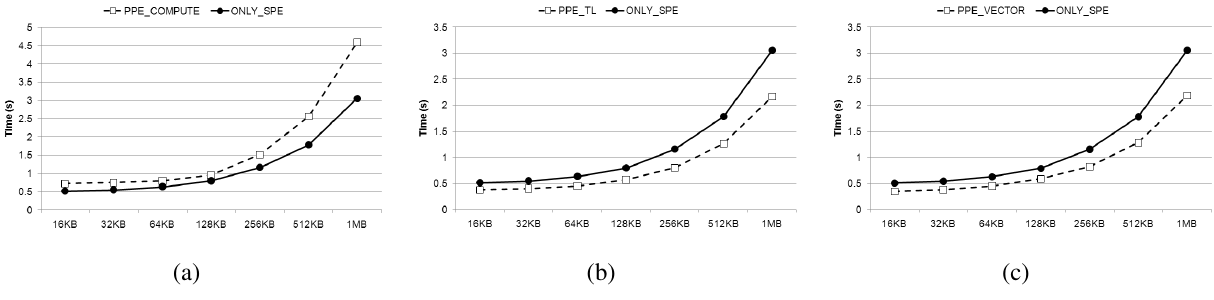
Decoding time of three algorithms which using PPE compared with only using SPEs with coefficient matrix size of 512; ( a ) PPE COMPUTE ; ( b ) PPE TL